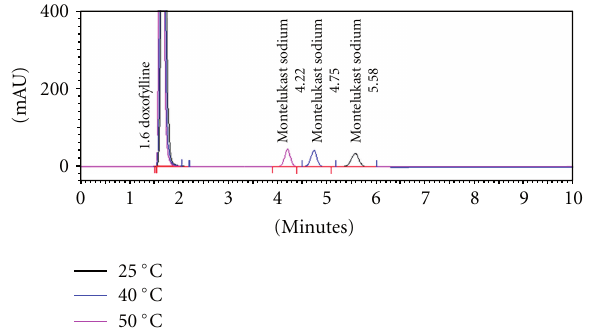
F 2: Temperature variation